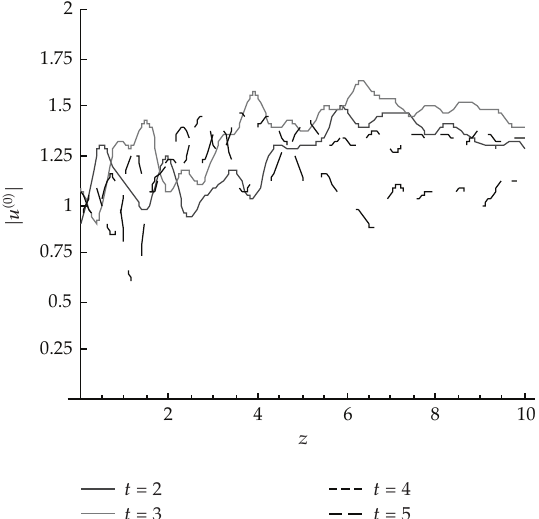
Figure 27: The zero-order approximation | u (cid:3) 0 (cid:4) | at α (cid:8) 1, T (cid:8) 10, γ (cid:8) 02 for di ff erent values of t , considering only one term in the series (cid:3) M (cid:8) 1 (cid:4)